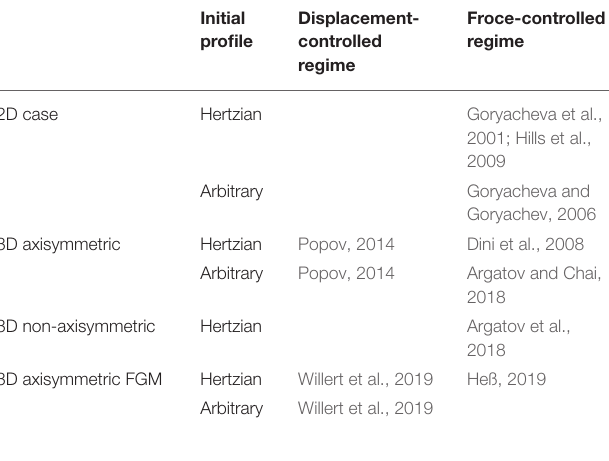
TABLE 1 | Limiting shapes of profiles in fretting